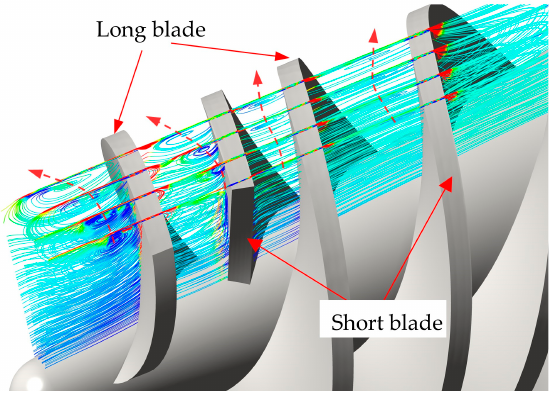
Figure 7. Motion of TC vortex (0.75 Q d , TC = 0.3 mm).